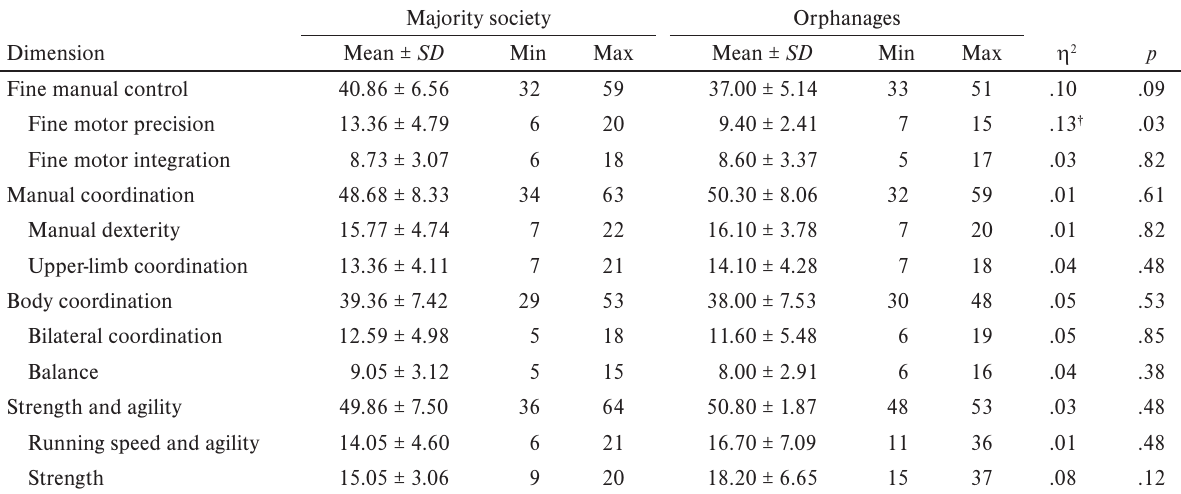
Descriptive statistics of all BOT-2 dimensions for boys from majority society and from orphanages Majority Dimension